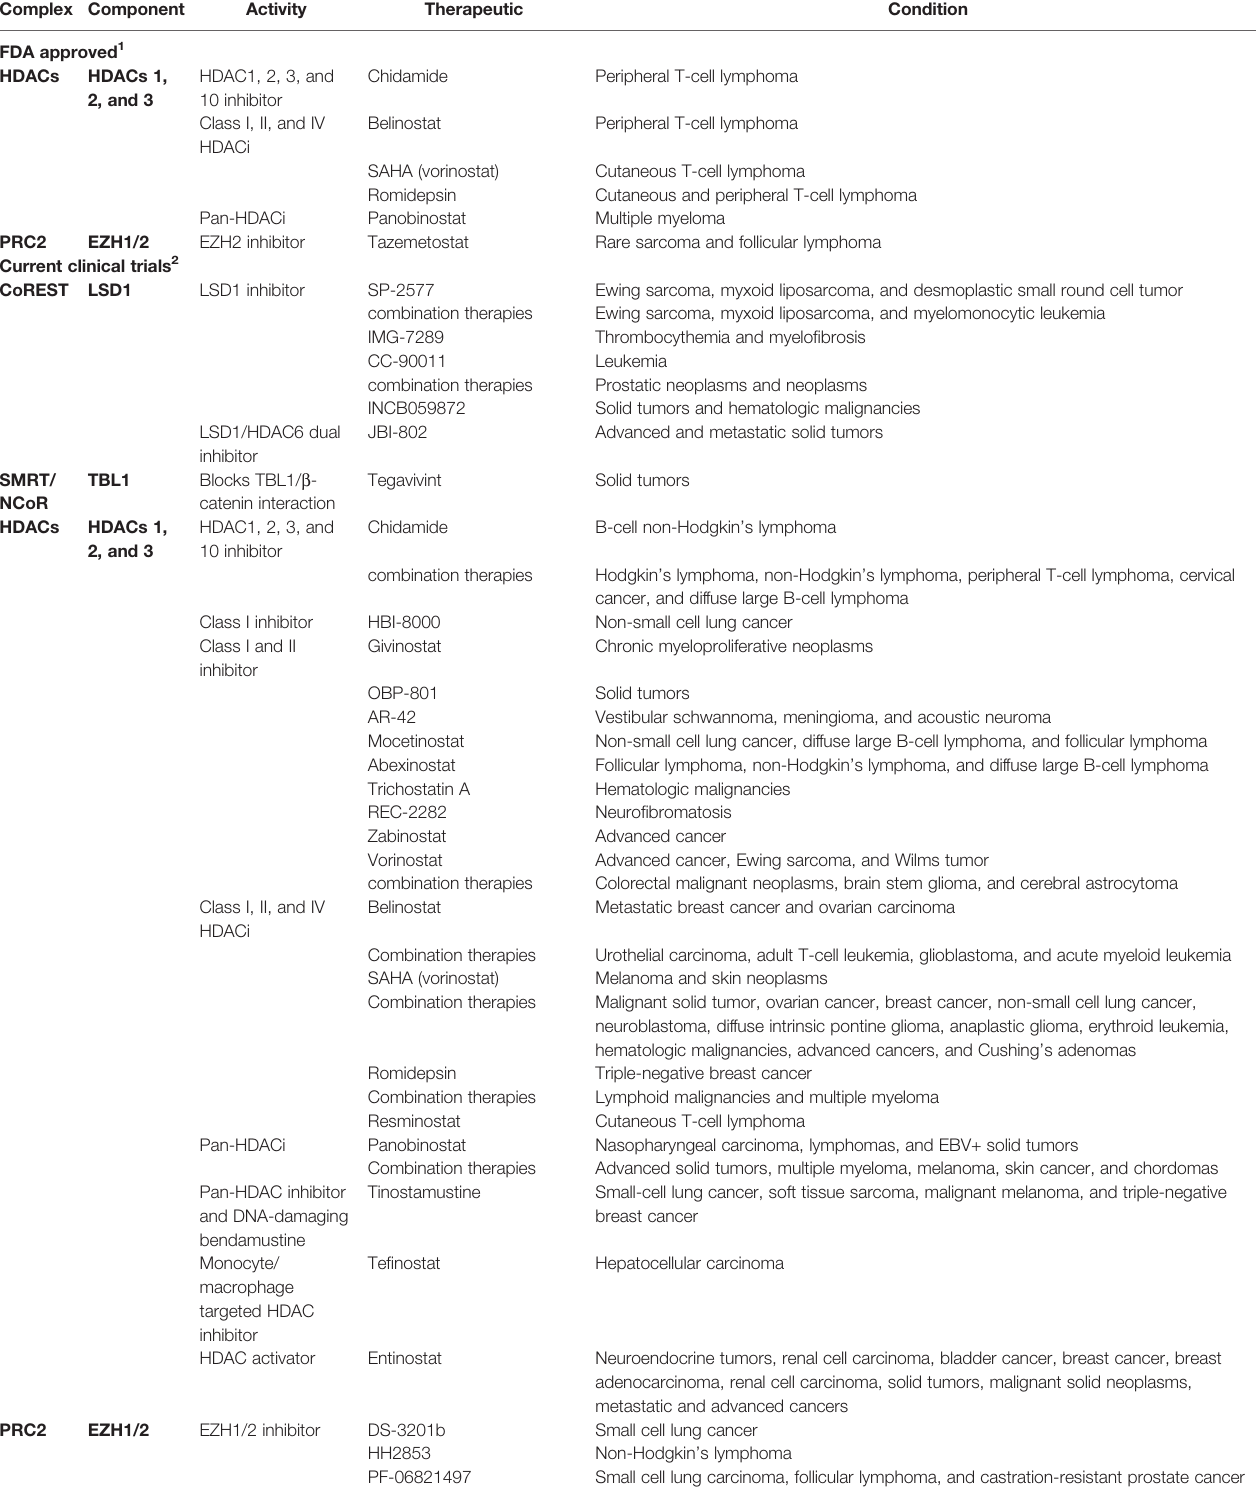
TABLE 2 | Epigenetic regulatory complex components targeted for anticancer